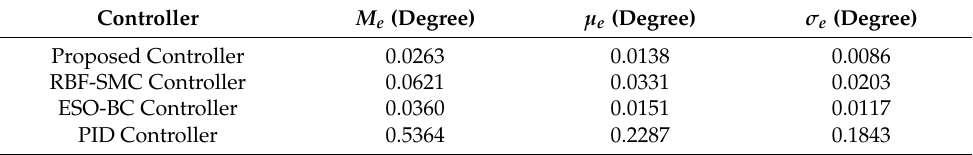
Figure 9. The tracking errors of the four controllers in fast-motion reference trajectory. Table 4. Performance indexes in fast-motion reference trajectory of all considered